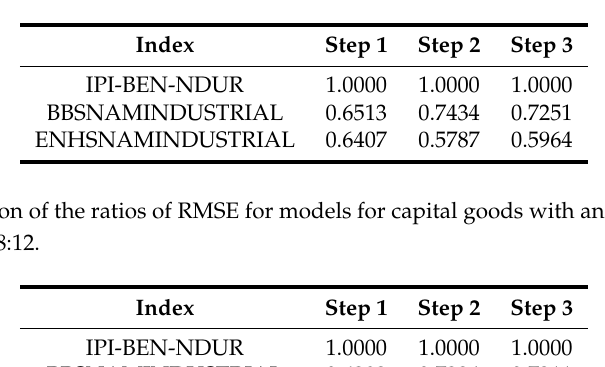
Table 16. Comparison of the ratios of absolute error for models for capital goods with an expanding window from 2008:01 to 2018:12.